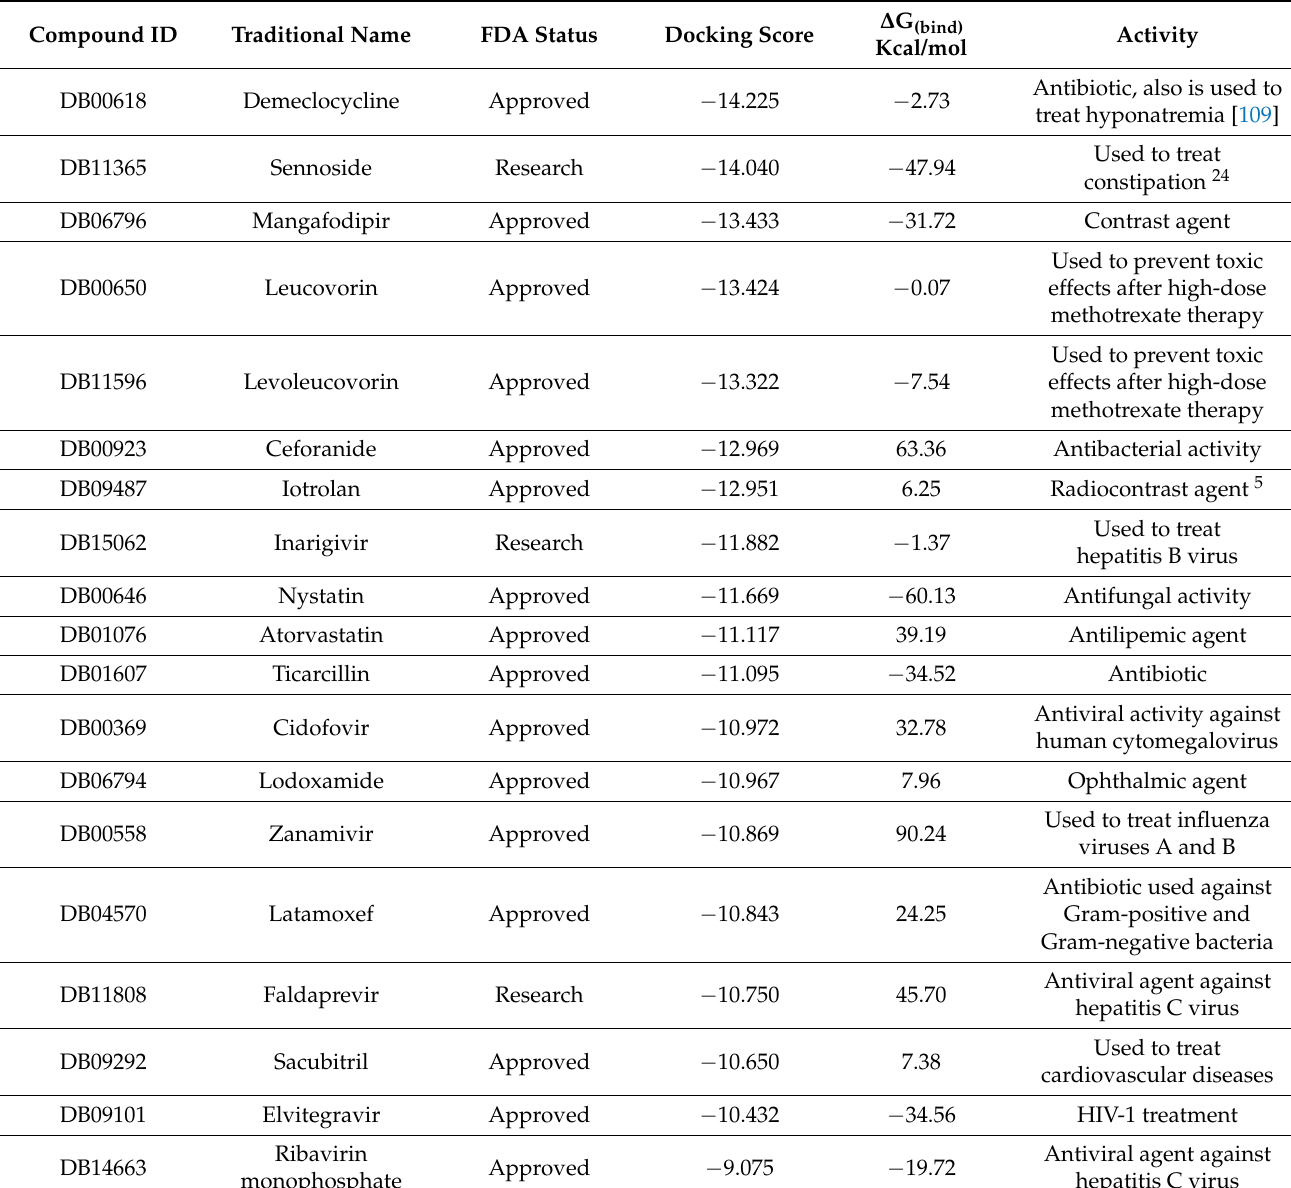
Table 3. Docking scores and binding-free energy calculations of the best-ranked FDA-approved drugs against RNA-dependent RNA polymerase